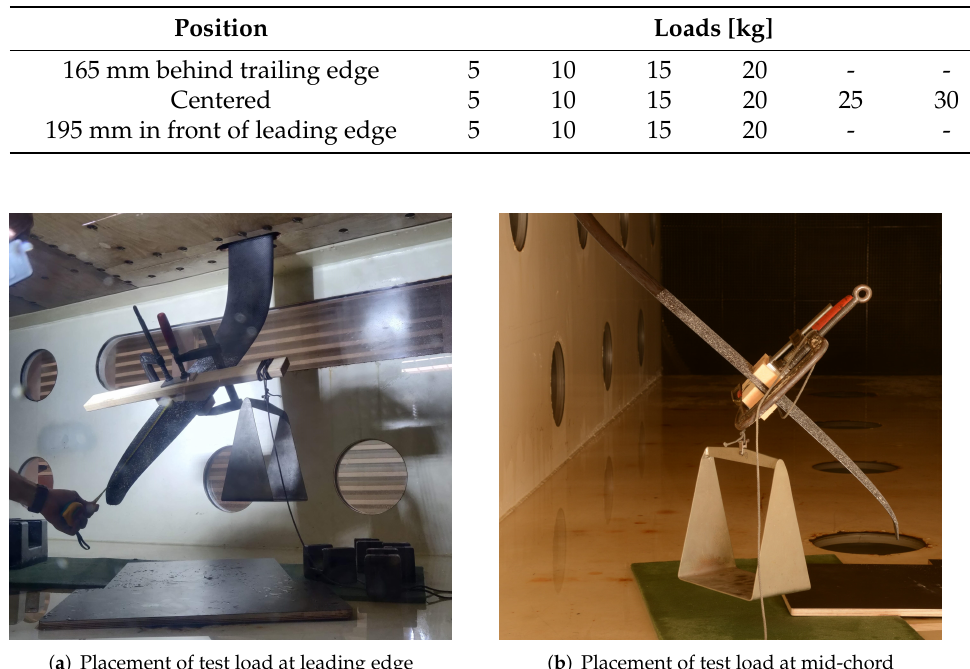
Figure 14. Placement of weights during static load test inside the cavitation tunnel test